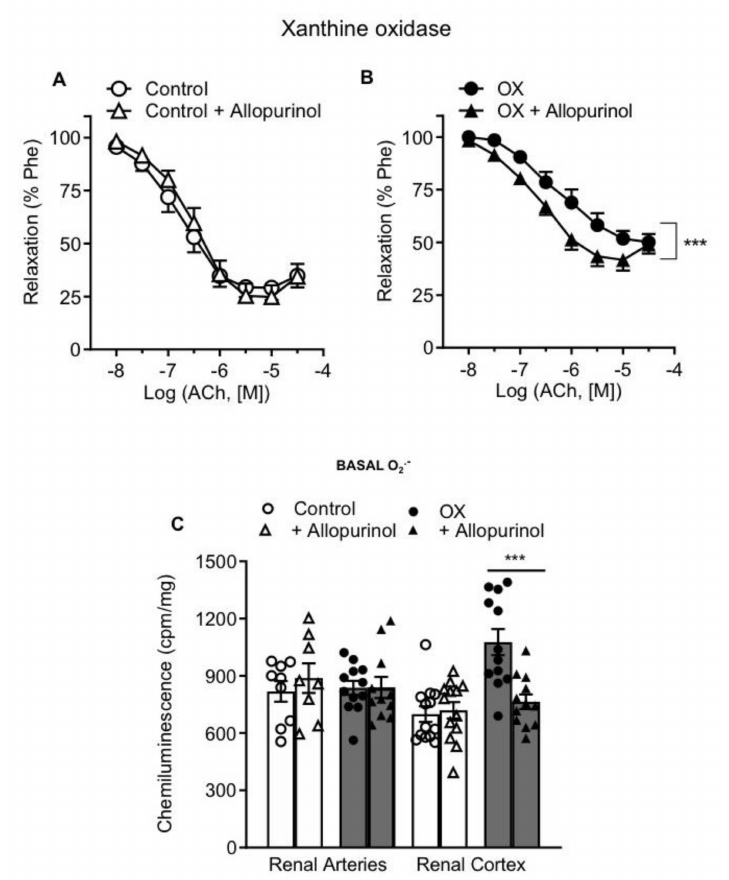
Figure 3. Xanthine oxidase inhibition reduced elevated O 2 − levels in the renal cortex from the OX group and improved impaired endothelial relaxations in the OX group. ( A , B ) Effect of the xanthine oxidase inhibitor allopurinol on the endothelial relaxations of rat intrarenal arteries in the control ( A ) and OX groups ( B ). Results are given as percentage of the phenylephrine (Phe) contraction as the mean ± SEM of 4 animals (1–2 arteries per animal). Statistical differences were calculated by paired Student’s t -test *** p < 0.001. ( C ) Effect of allopurinol on basal ROS generation in the kidney cortex and renal interlobar arteries measured by lucigenin-enhanced chemiluminescence. Results are expressed as counts per minute (cpm) per mg of tissue. Bars represent mean ± SEM of 5–10 animals. Statistical differences were calculated with t -test *** p < 0.001 versus basal